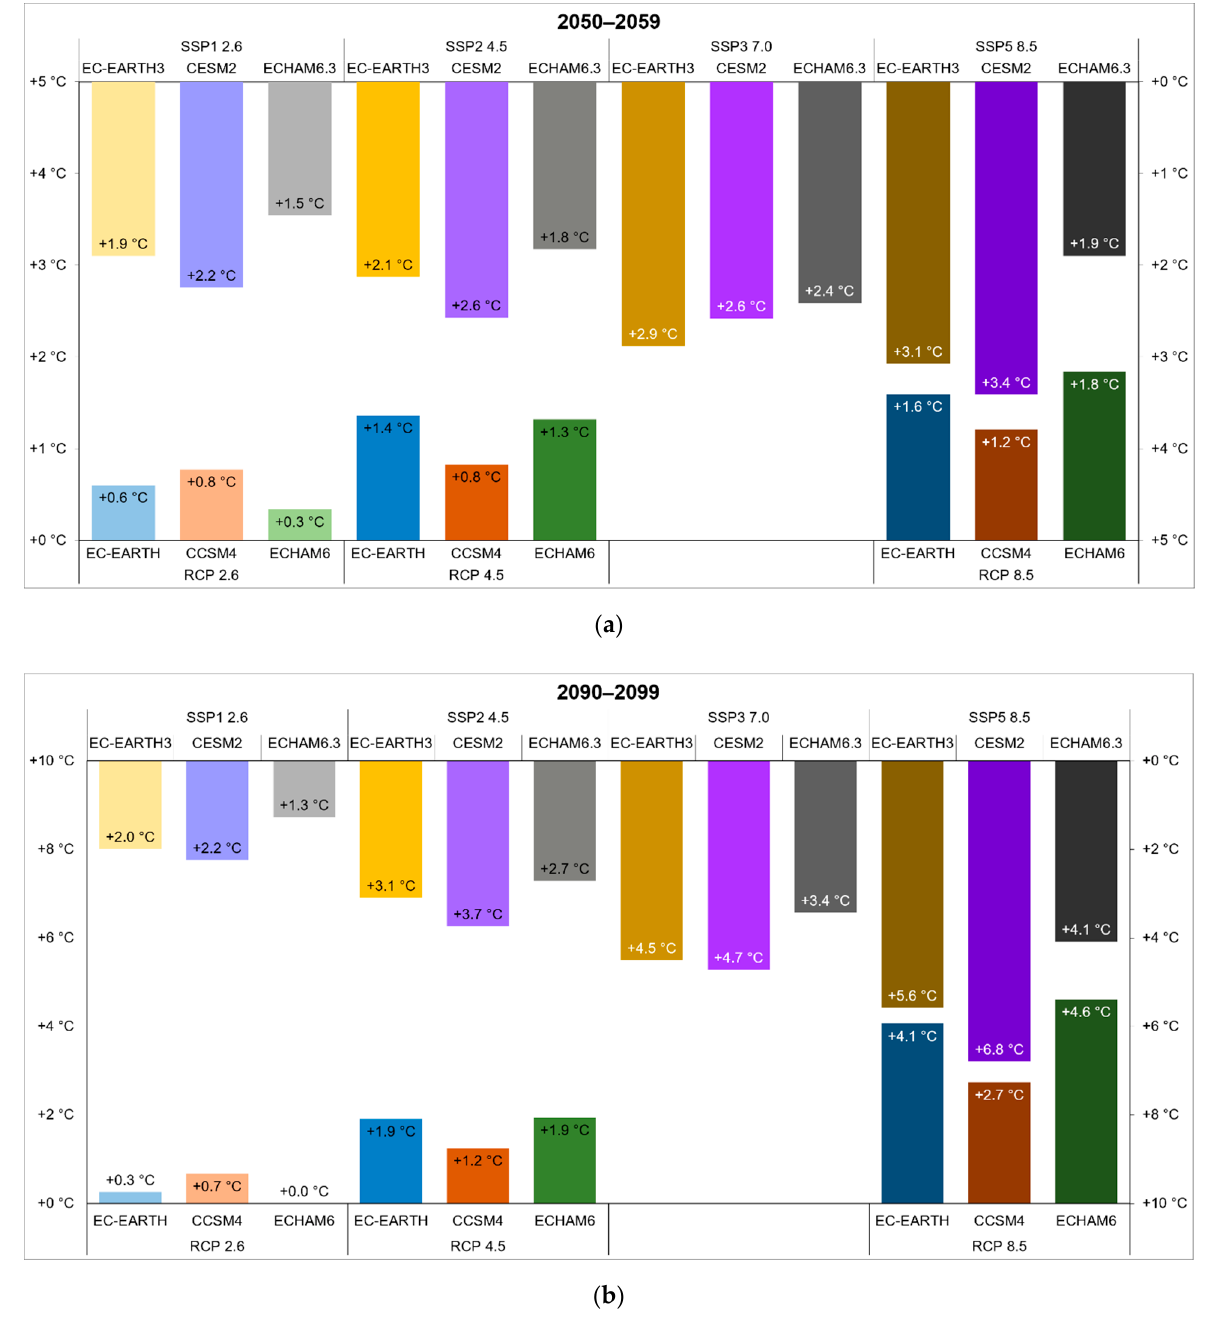
Figure 6. Average yearly temperature variations. ( a ) Mid Century P1. ( b ) End of Century P2.